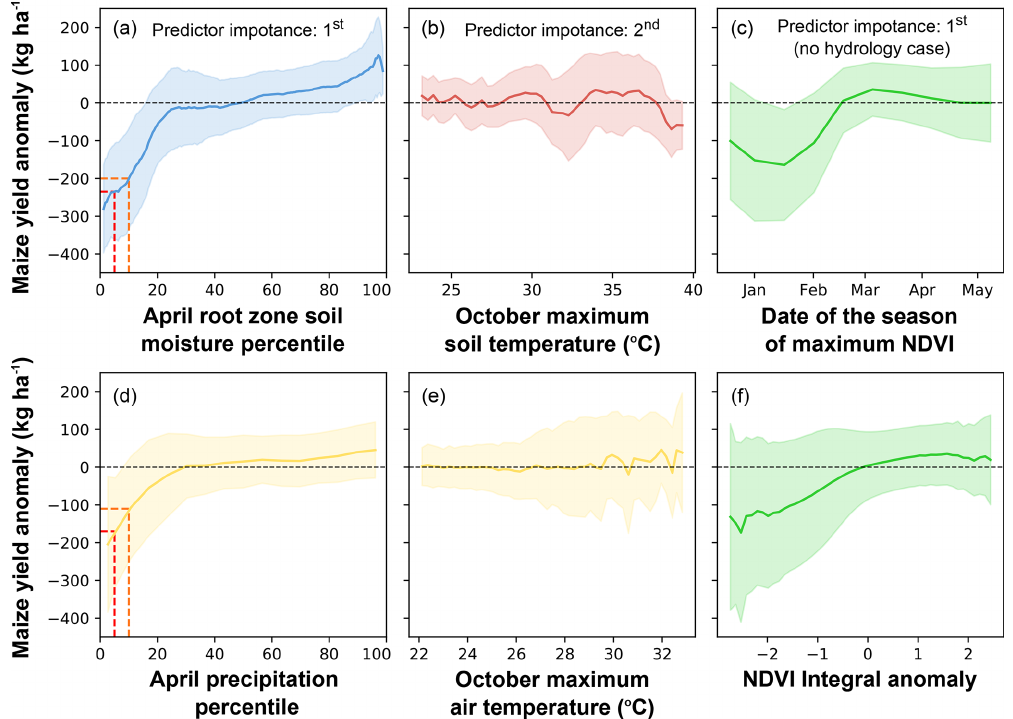
Figure 7. The relationship between the field-scale maize yield anomalies with respect to the six drought indicators identified in Table 3. Panels (a–c) show the most predictive variables, and panels (d–f) show the (respective) commonly used variables. Dark lines show the mean values, and shades show the standard deviation. Red and orange dashed lines illustrate potential drought